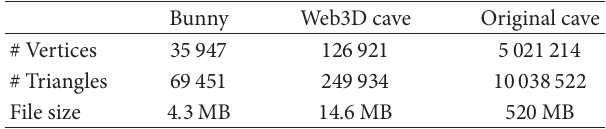
Table 5: Complexity in terms of the number of vertices, faces, and the X3D file size for the bunny, the Web3D, and the original cave chamber